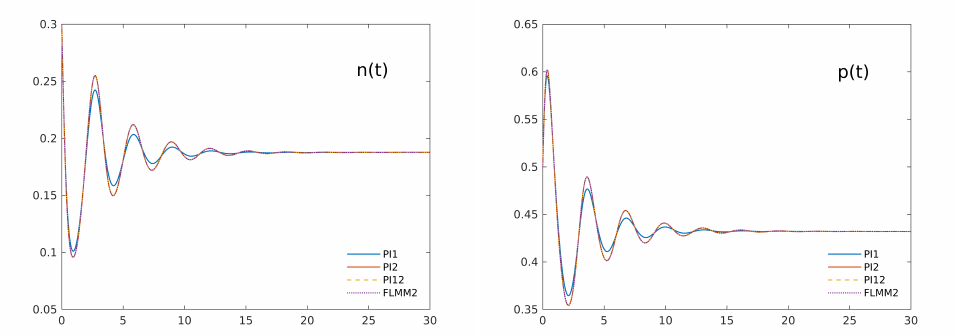
Figure 2. Trajectories for all the numerical approximations of the solutions of system (3) in case θ = 0.9. While the corresponding ODE systems show instability (see the right panel of Figure 1), the trajectories of the fractional system rapidly stabilizes for both variables ( n ( t ) shown in the left panel, p ( t ) in the right one). The lowest order approximation PI1 clearly shows more damped oscillations, while the higher order approximations are all in excellent